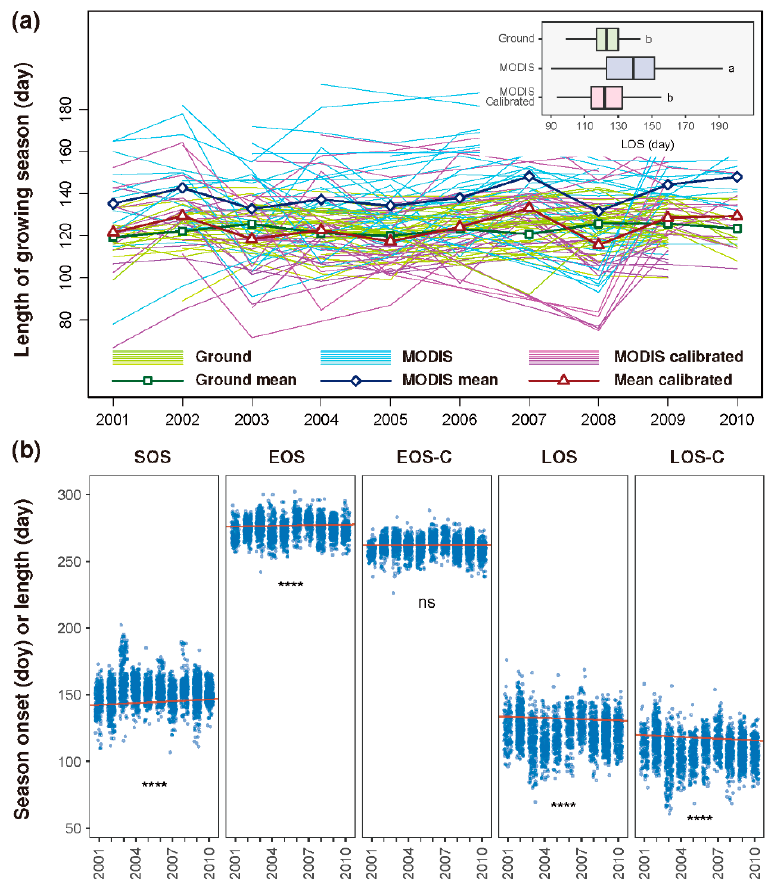
Figure 10. ( a ) Temporal variations in cropland growing season length (LOS) per station in Northeast China from 2001 to 2010. Each thin line represents a station. Each thick line with hollow markers represents the mean of all stations. Inset: Overall comparison between ground-observed and MODIS-derived versus climotransfer function-calibrated LOS. Boxplots with different lower-case letters indicate a significant difference ( p < 0.001); ( b ) Temporal trend (solid line) in the cropland growing season based on annual time series (clustered dots) of the season start (SOS), end (EOS), and length (LOS) at the pixel scale. EOS-C and LOS-C are calibrated EOS and LOS, respectively. ****, p < 0.0001; ns, not significant.